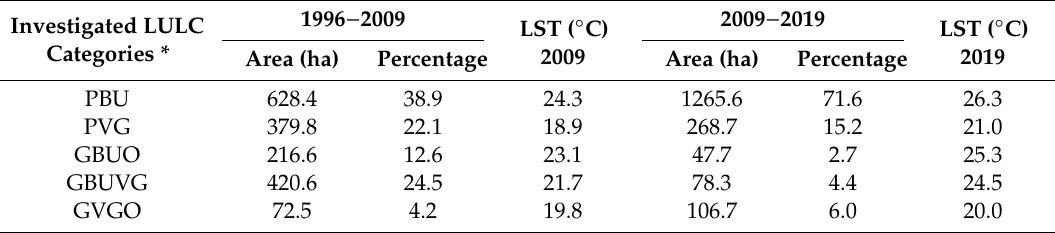
Table 2. Changes of BU and VG lands from 1996 to 2019 in the Galle Municipal Council (GMC) area. LST, land surface temperature; PBU, persistent built-up; PVG, persistent vegetation; GBUO, gain of built-up from others; GBUVG, gain of built-up from vegetation; GVGO, gain of vegetation from others. Investigated